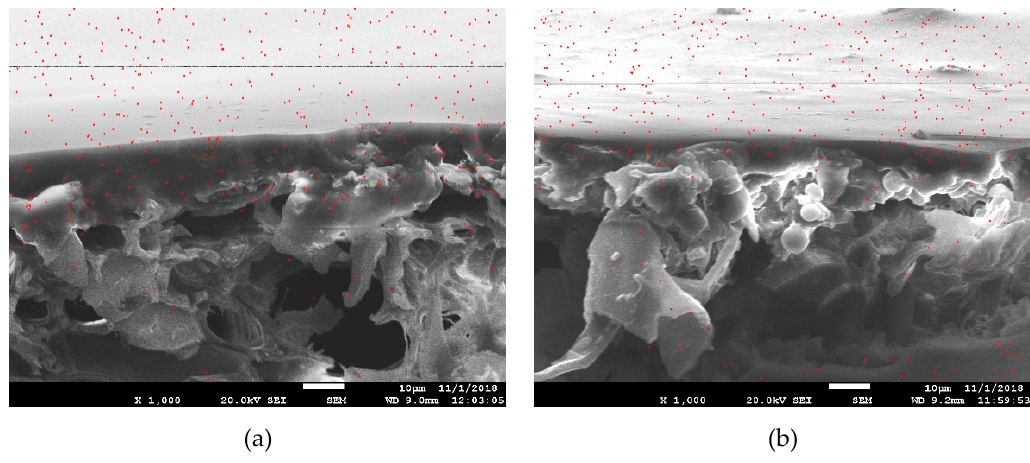
Figure 8. SEM-EDXA images for N distribution of oak after coating at different coating amount. (a) 12 g/m 2 PUA coated oak; (b) 60 g/m 2 PUA coated oak; the magnification was × 1000.